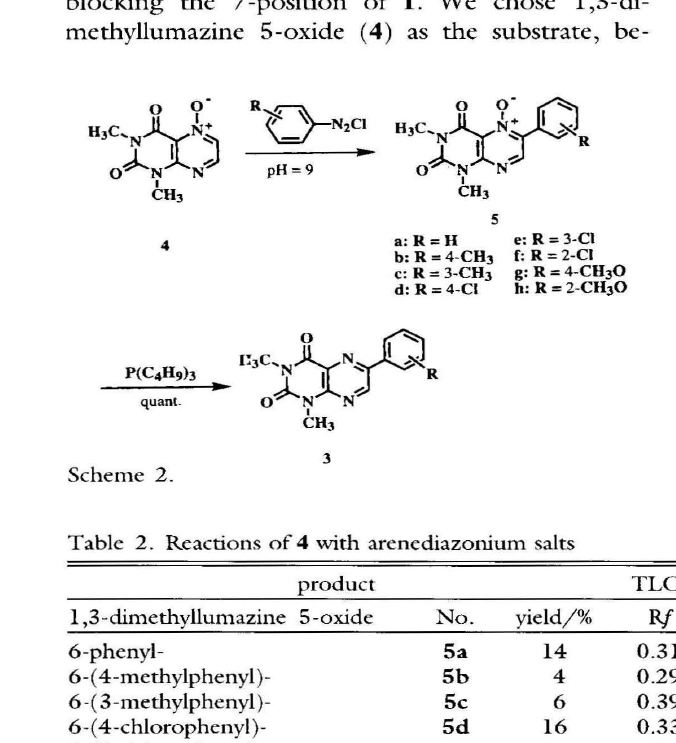
Table 2. Reactions of 4 with arenediazonium